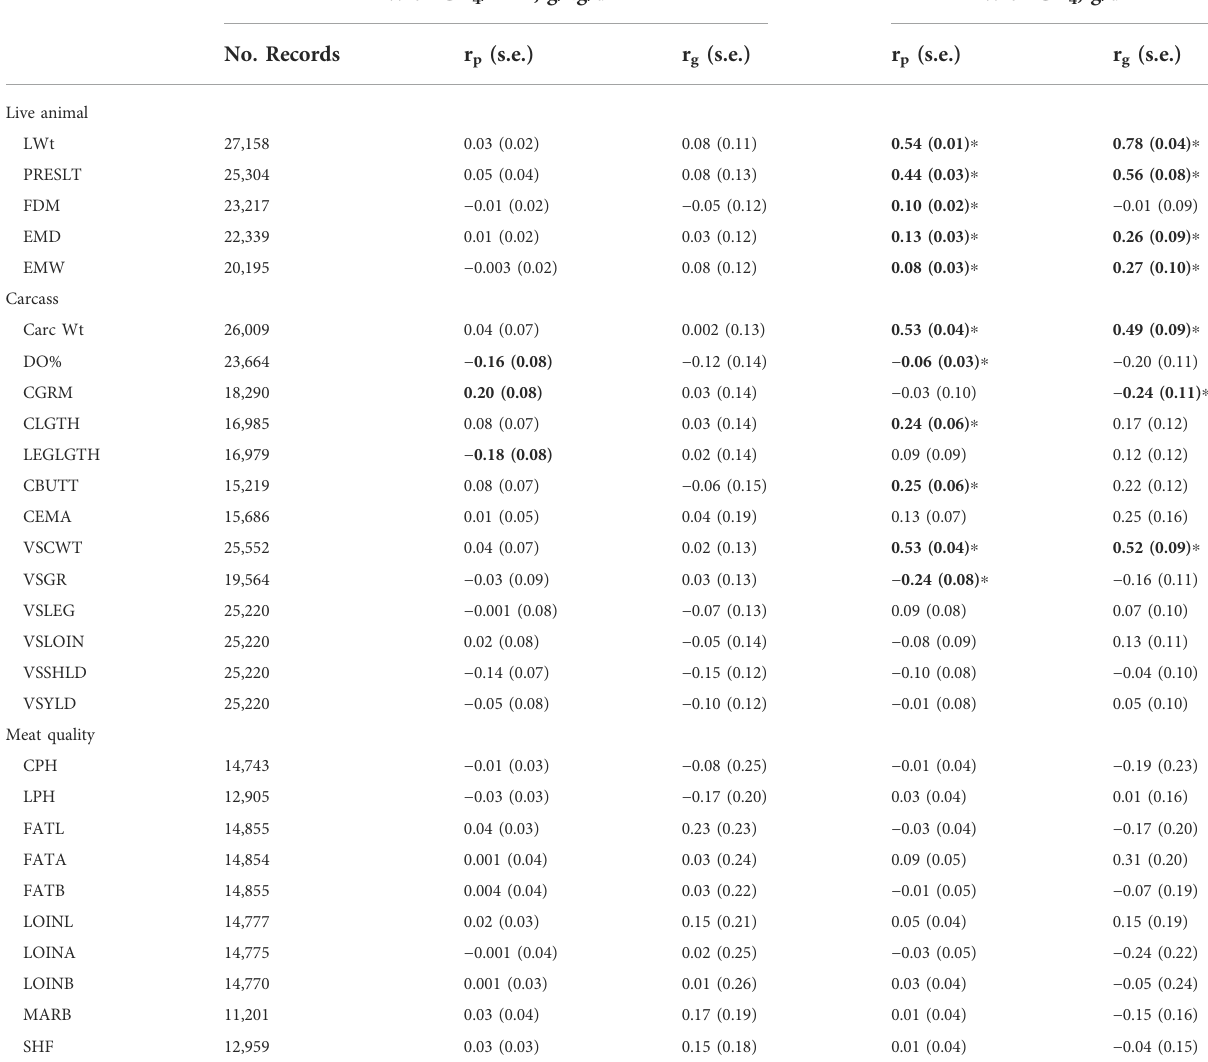
TABLE 3 Phenotypic (r p ) and genetic (r g ) correlations between methane emissions (g CH 4 /d) and methane yield (g CH 4 /kg DMI/d) with live animal, carcass, and meat quality traits. Signi fi cant correlations (estimate is greater than twice the standard error) are given in bold. See Table 1 for trait